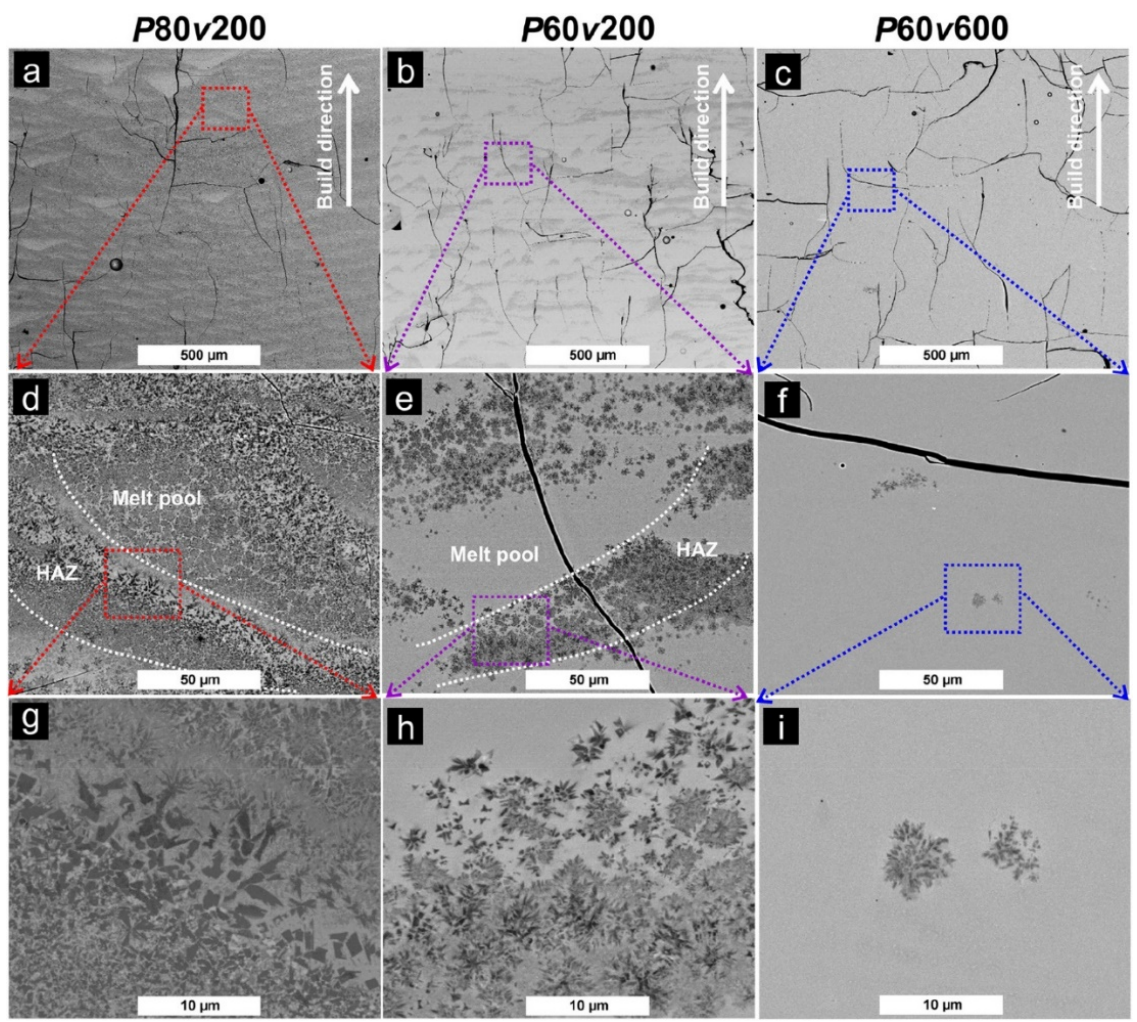
Figure 32. Microstructure of a Fe-based BMG fabricated via LPBF using three sets of laser parameters ( P is the power (W), v is the scanning speed (mm/s)). ( a ) Microstructure of the sample fabricated with the power of 80 W and scanning speed of 200 mm/s, ( b ) microstructure of the sample fabricated with the power of 60 W and scanning speed of 200 mm/s, ( c ) microstructure of the sample fabricated with the power of 60 W and scanning speed of 600 mm/s, ( d ) higher magnification of ( a ), ( e ) higher magnification of ( b ), ( f ) higher magnification of ( c ), ( g ) higher magnification of ( d ), ( h ) higher magnification of ( e ), and ( i ) higher magnification of ( f ). Reproduced from [68], with permission from Elsevier, 2021.